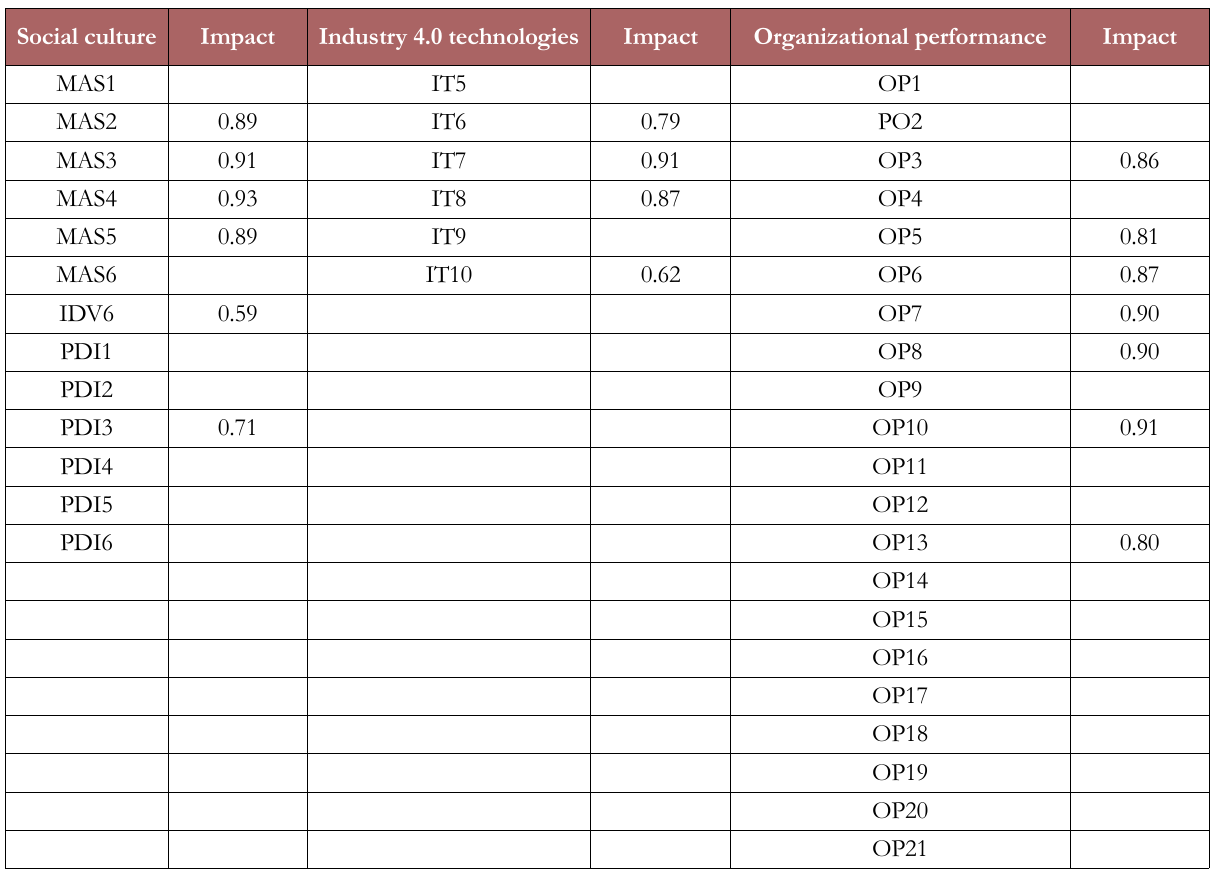
Table 4. Fit indices and non-standardized coefficients for the iterations of the CFA for the dimensions of SC, IT, and